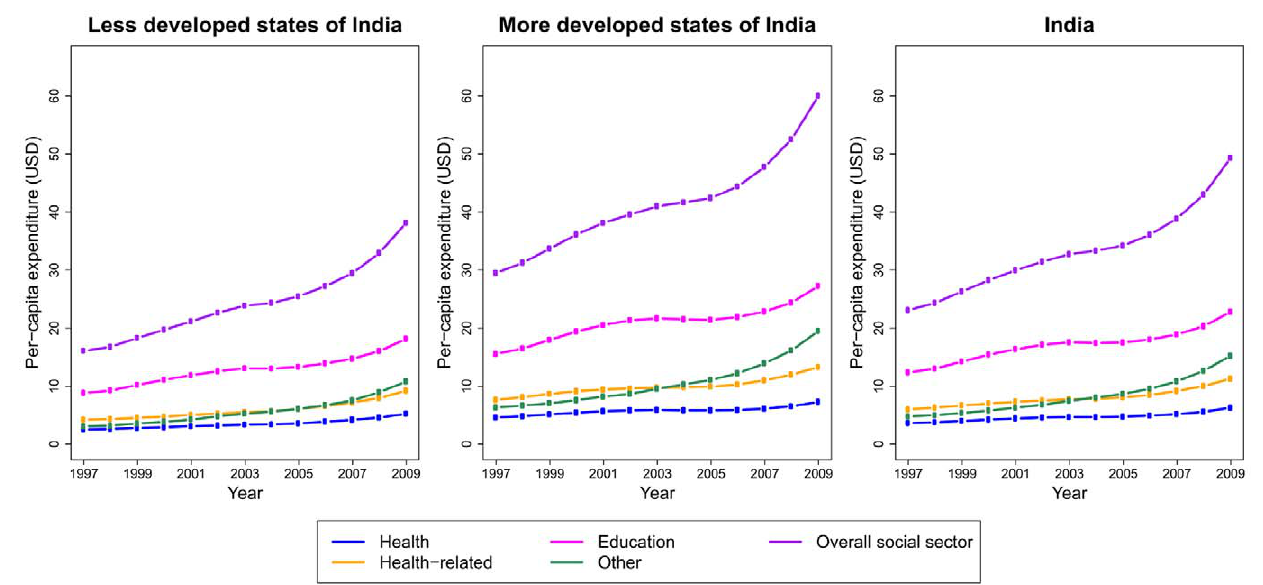
Figure 1. Per-capita health, health-related, education, other, and overall social sector expenditure, 1997–2009. Per-capita expenditure is calculated as the sum of yearly expenditure across all states in our analysis divided by the sum of yearly population in these states and averaged for the five years ending in the index year. Expenditure is shown in constant 2009 prices (USD). Trends are shown for the less developed and more developed state of India and for India as a